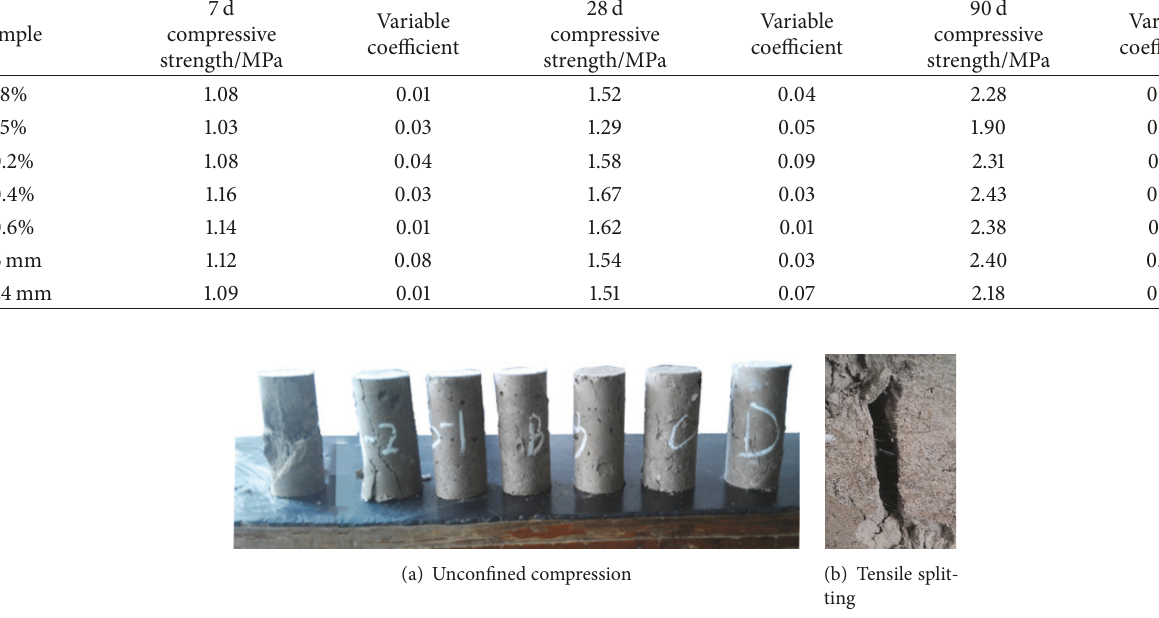
Figure 3: Failure modes of the unconfined compression test and tensile splitting test.